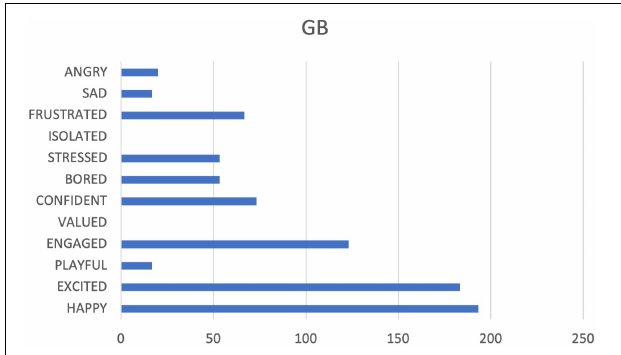
FIGURE 8 | Cumulative frequencies of GB data